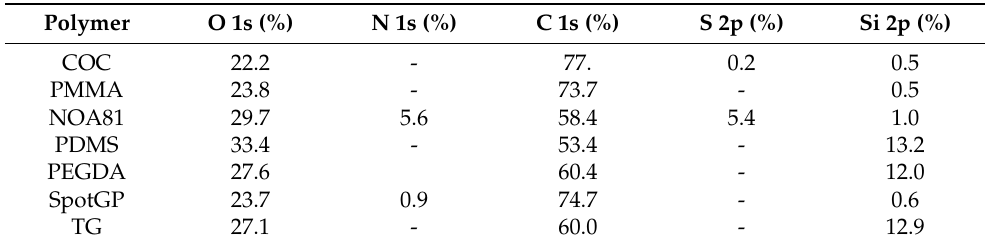
Table 2. XPS analysis at 0 ◦ take-off angle of all polymers studied. The standard error does not exceed the 1–2% of the reported